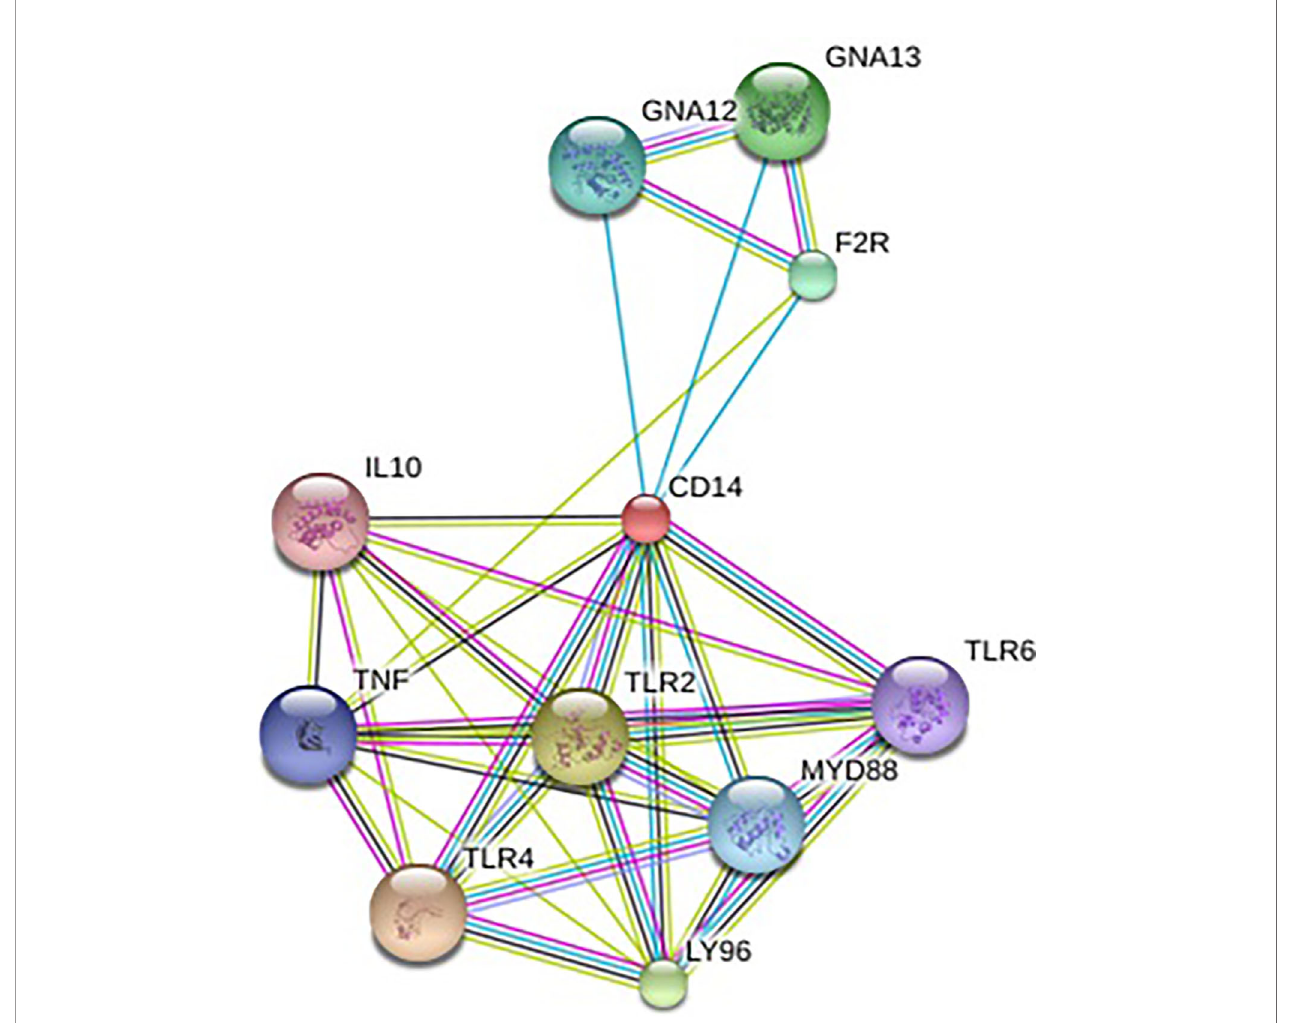
FIGURE 6 | String network-Molecular interaction of ovine CD14 molecule with other related